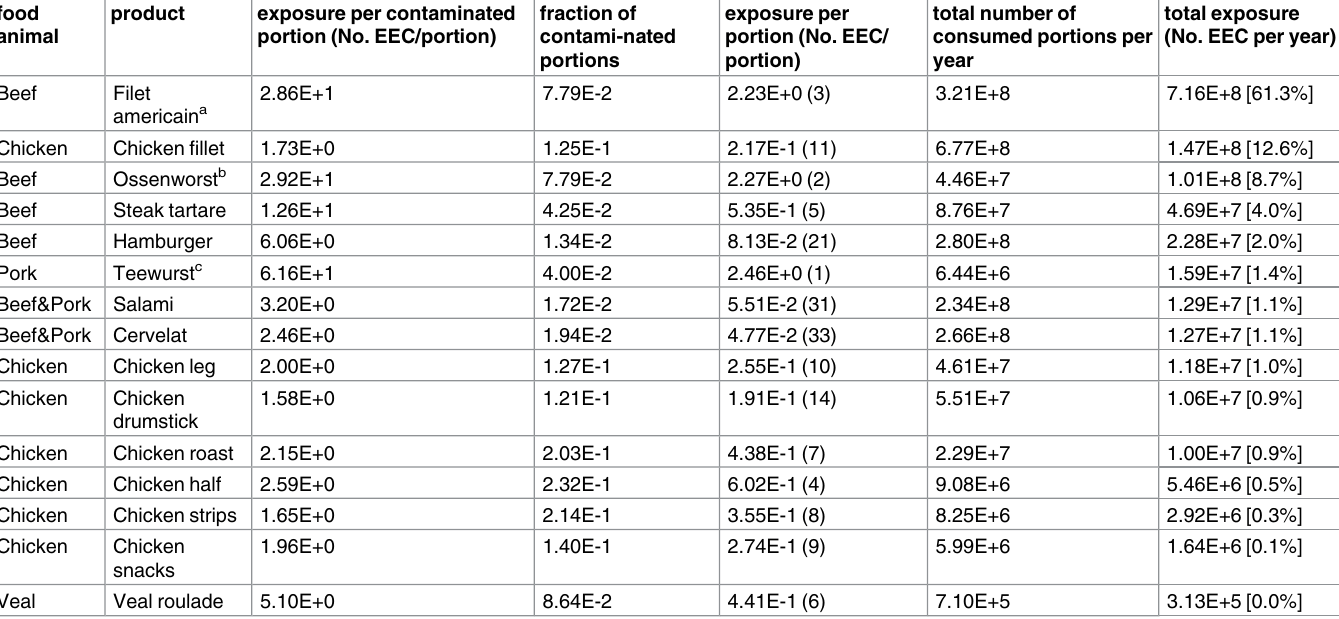
fifth column; see caption for a description of these products). The full top 10 of EEC exposure per portion (fifth column) consisted on the one hand of chicken products which were Table 8. Contribution of different food products to the exposure of humans to EEC through meat at the moment of consumption. food animal